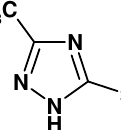
Figure 1. Chemical structure of